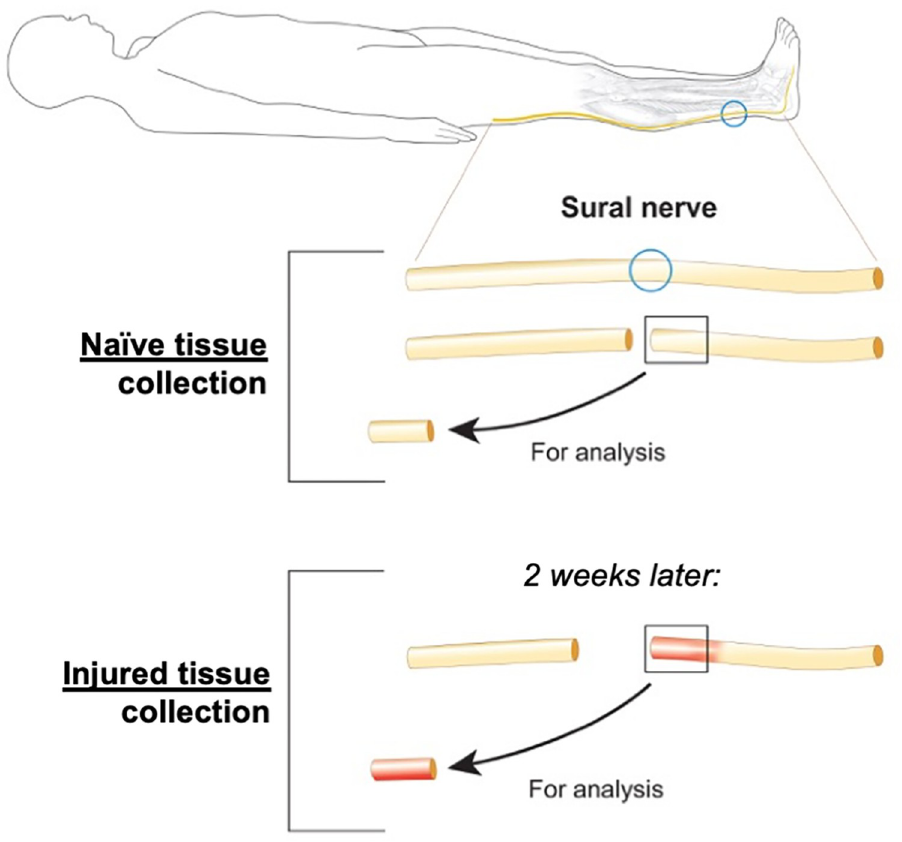
Fig 1. Study overview. Schematic to illustrate the timing and location of the sural nerve injury and tissue